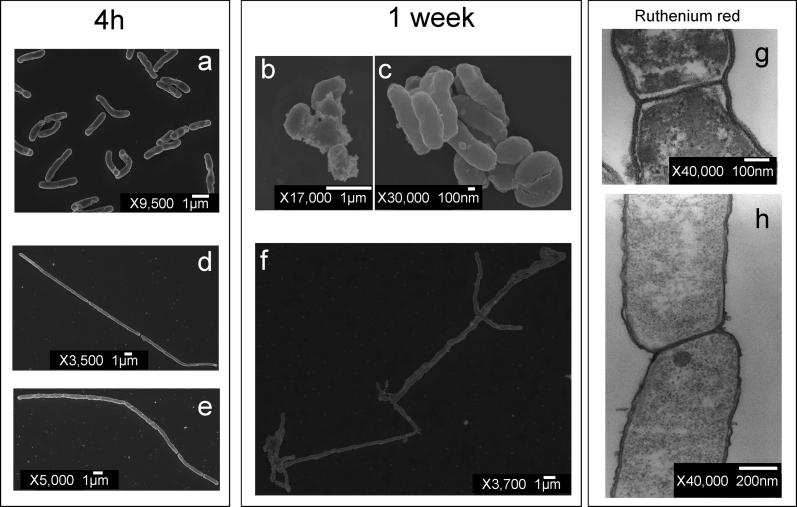
Morphologies of H. pylori
(A–F) SEM of H. pylori during exponential-phase growth (4 h of culture (A, D, and E) and after 1 wk of culture (B, C, and F) of the parental strain 26695 (A–C) and the amiA mutant (D–F).(G and H) TEM sections of the amiA mutant after ruthenium staining. The amiA mutant is able to form a complete septum without final daughter cell separation. Chains of the amiA mutant contained up to 30–40 bacteria.